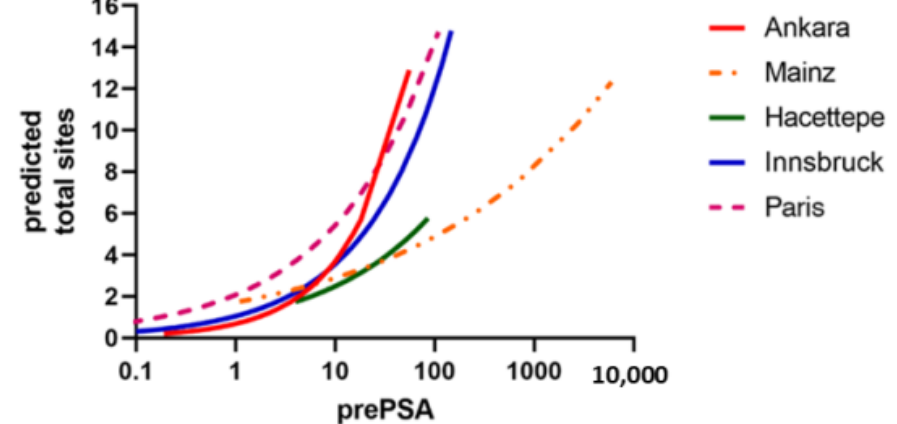
Figure 2. The five cohorts had grossly similar relation between the prescan PSA and the number of positive sites on the restaging PSMA PET/CT. The cohorts are named by the cities for the study centers.